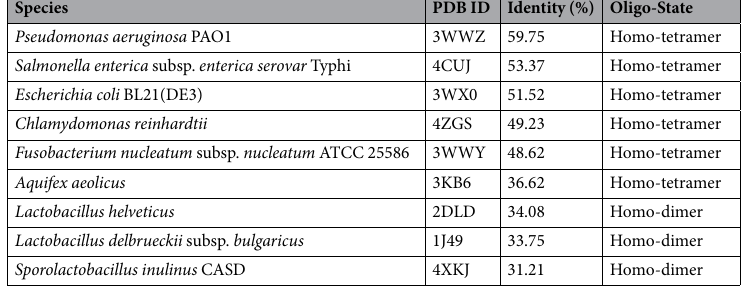
Table 3. A list of Ddhs from nine organisms showing the homology to Sy Ddh and predicted quaternary structure. An amino acid sequence of Sy Ddh was used as a query and searched by SWISS-MODEL (https://